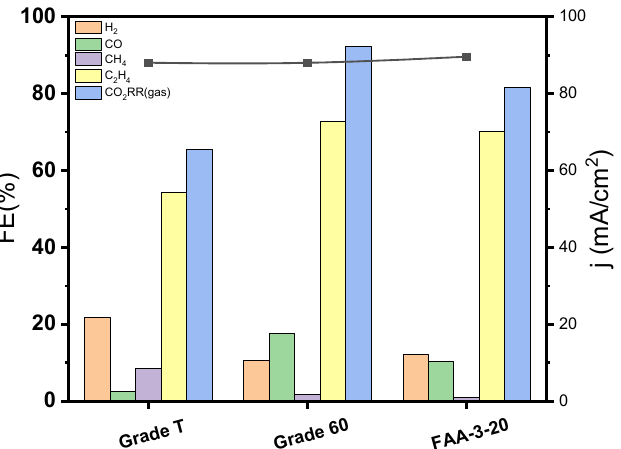
Figure 9. The Faraday efficiency of gas products and current density with different membranes. Operating parameter: Cell voltage 4.2 V, CO 2 gas flow rate of 10 sccm, anolyte flow rate of 10 sccm, and the channel type of series microchannel structure.